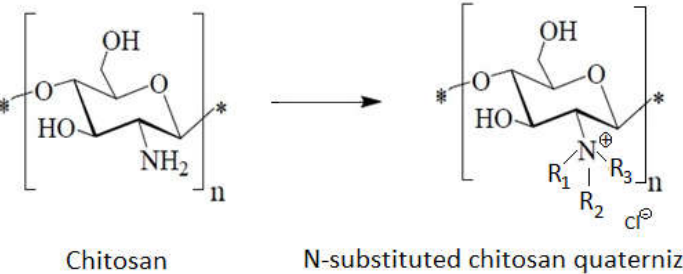
Figure 11. General structure of N-alkyl chitosan derivatives. Different degrees of quaternization of amino groups in chitosan can be obtained via methyl iodide of N-methyl pyrrolidinone, in alkaline medium [99]. Quaternized derivates of chitosan, such as N,N,N-trimethyl chitosan chloride, are more soluble in water than chitosan in a wide pH and concentration range. These demon- strate that chitosan acts as an absorption enhancer for test drugs